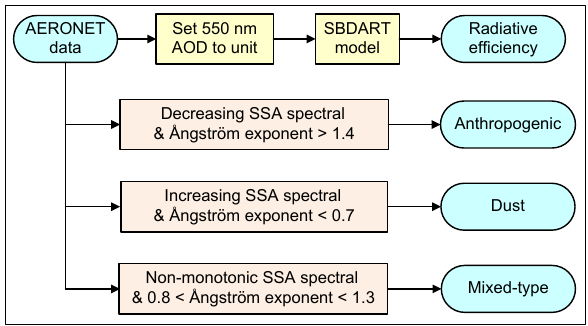
Figure 1. Diagram of the radiative efficiency calculation and aerosol